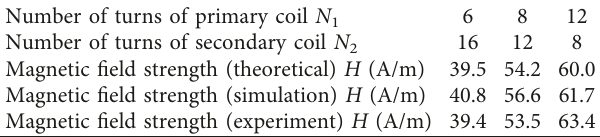
Table 8: Electromagnetic radiation distance.